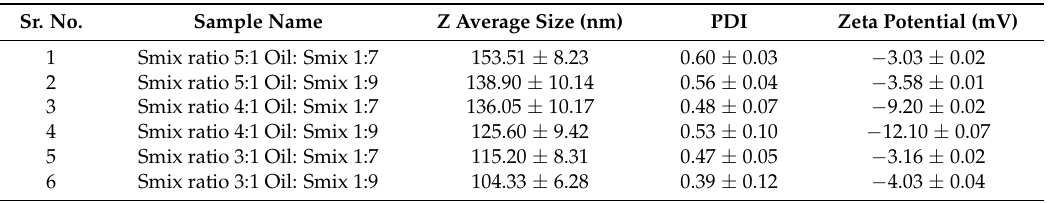
Table 3. Globule size, Polydispersity Index (PDI) and Zeta potential of nanoemulsion comprising of tween 80: Carbitol ® as S mix and cinnamon